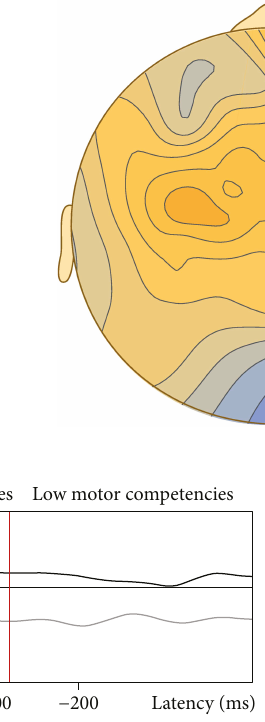
Figure 3: Comparison of the tCNV component ( − 500ms to S2 onset) of event-related potentials between adolescents with low and high motor competencies using cluster-based permutation testing. Note: there was no signi fi cant di ff erence between groups in the speci fi ed latency range; negative values denote greater negative amplitudes in adolescents with low motor competencies compared to those with high motor